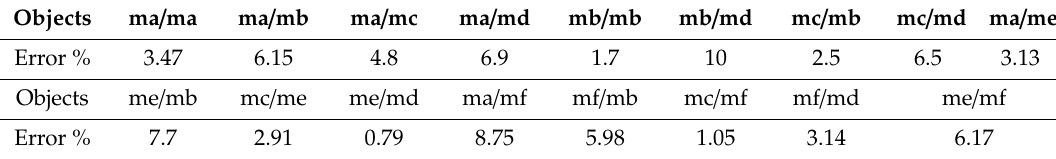
Table 1. Percentage error between mass ratio of the true value and the estimated